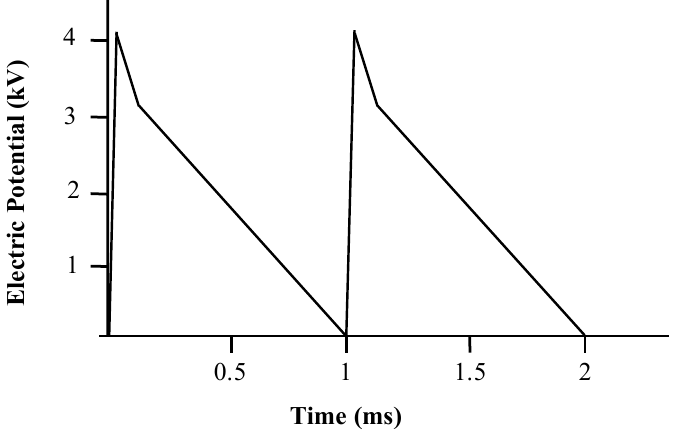
Figure 2. Voltage pulse waveform corrected to a closed circuit with an equivalent resistance of 120 M Ω obtained with an analogic oscilloscope.